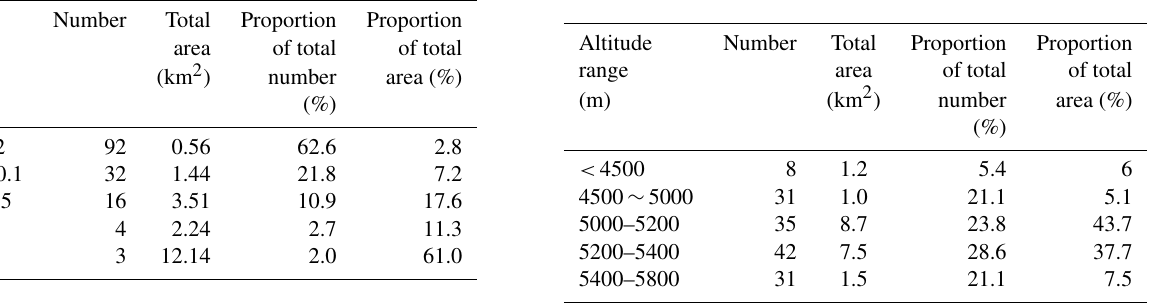
Table 4. Altitude distribution of glacial lakes in the Poiqu River basin.